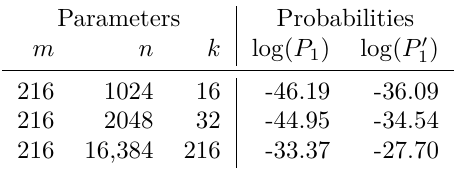
Table 3: Repeating ( P 1 ) and non-repeating double errors ( P ′ parameters of